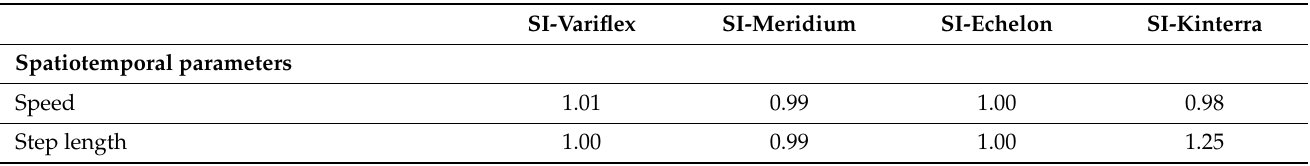
Table 3. Symmetry index for kinematic and kinetic outcomes during the four